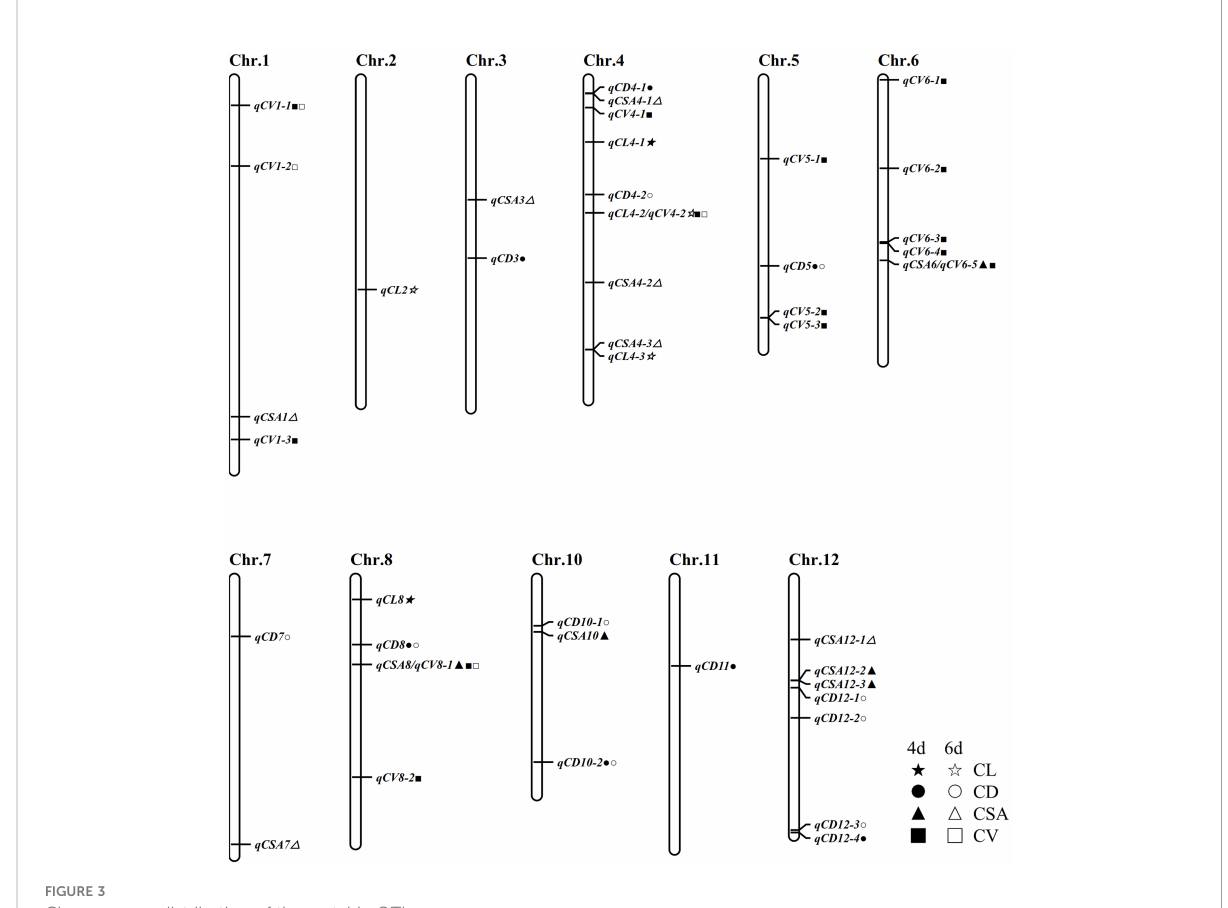
FIGURE 3 Chromosome distribution of these stable QTLs.